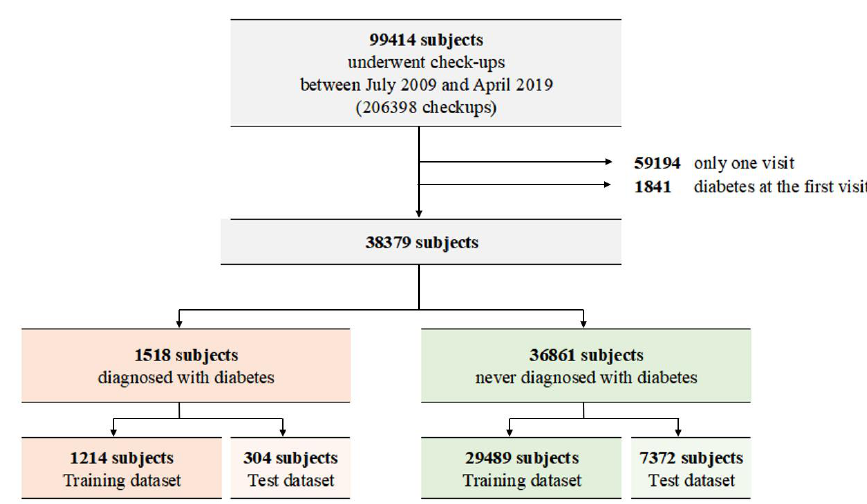
Figure 1. Description of the enrolled subjects.